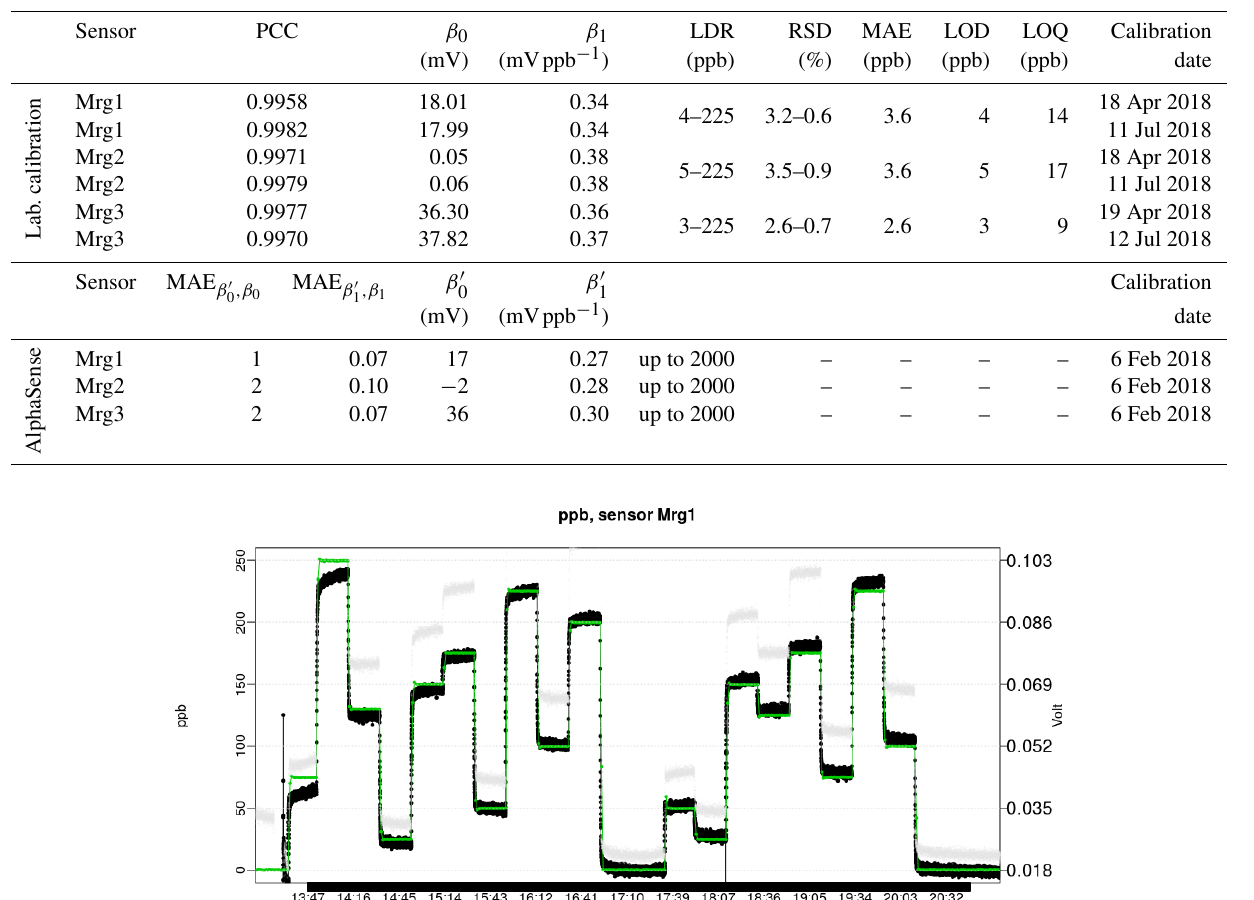
Table 1. In the first half of the table, the linear model regression coefficients and accuracy metrics obtained during the laboratory calibration are reported. Pearson correlation coefficient (PCC), intercept ( β 0 ), regression coefficient ( β 1 ), linear dynamic range (LDR), relative standard deviation limits (RSD), bias (MAE), limit of detection (LOD) and limit of quantification (LOQ) are shown. In the second half of the table, below the regression coefficients, intercept ( β (cid:48) ) and slope ( β (cid:48) ) transcribed from sensor’s data sheet are reported. Mean absolute error (MAE) 0 1 between β (cid:48) and β i (averages) is given in the first two columns. LCS statistics have been performed over 300 1s values for each ozone i